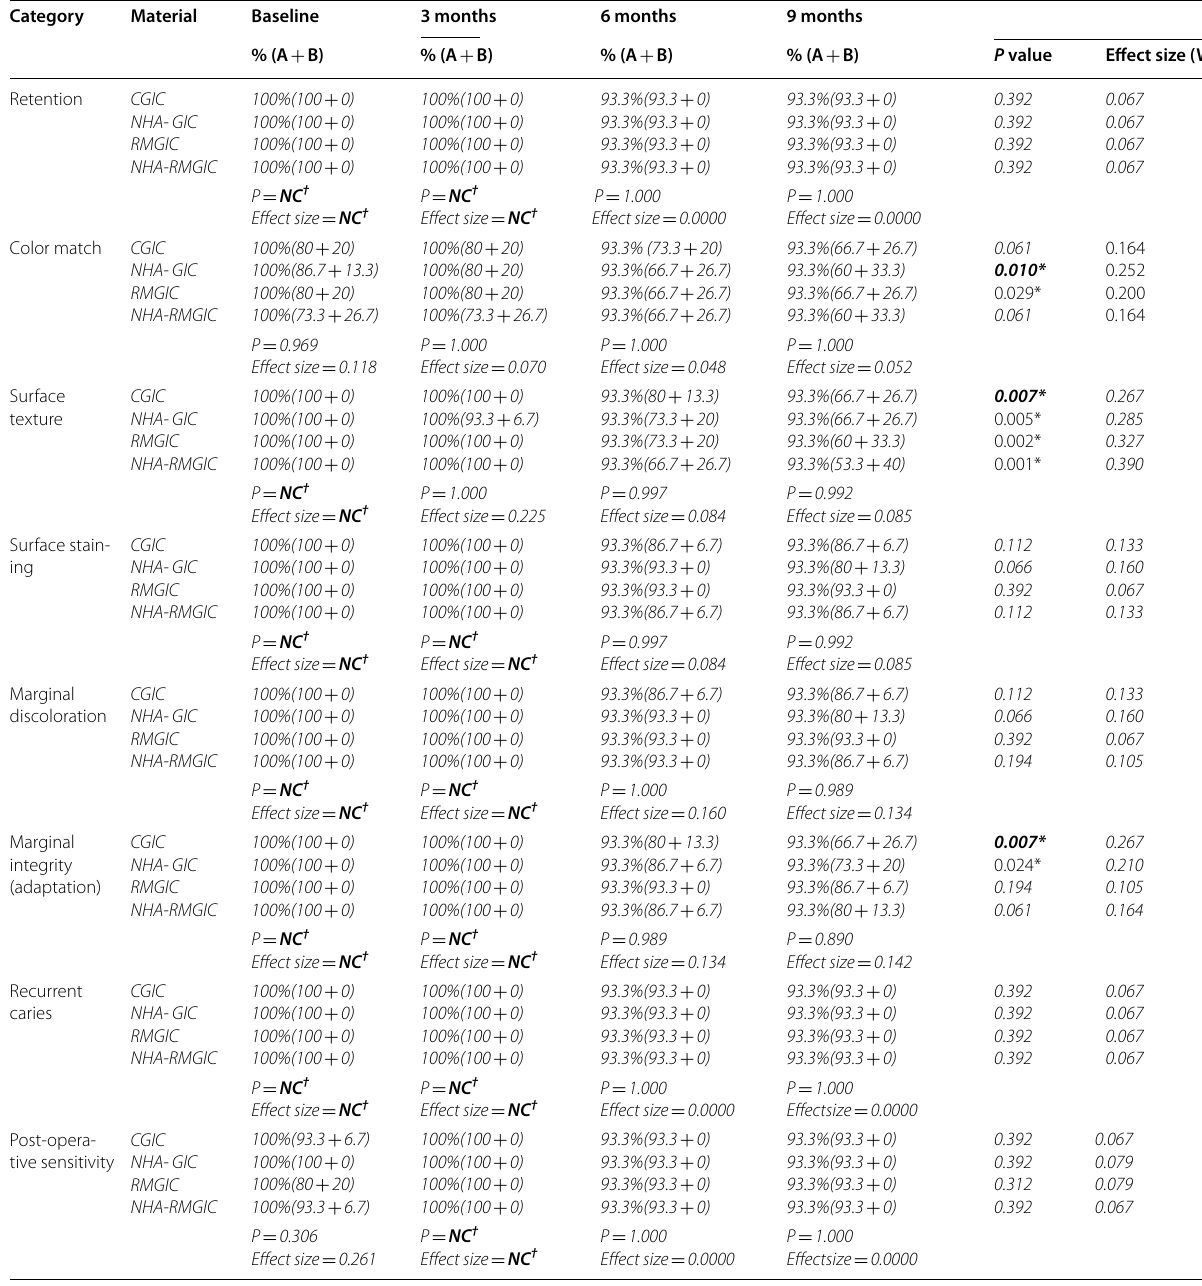
Table 5 Descriptive statistics and results of Fisher’s Exact test for comparison between the four